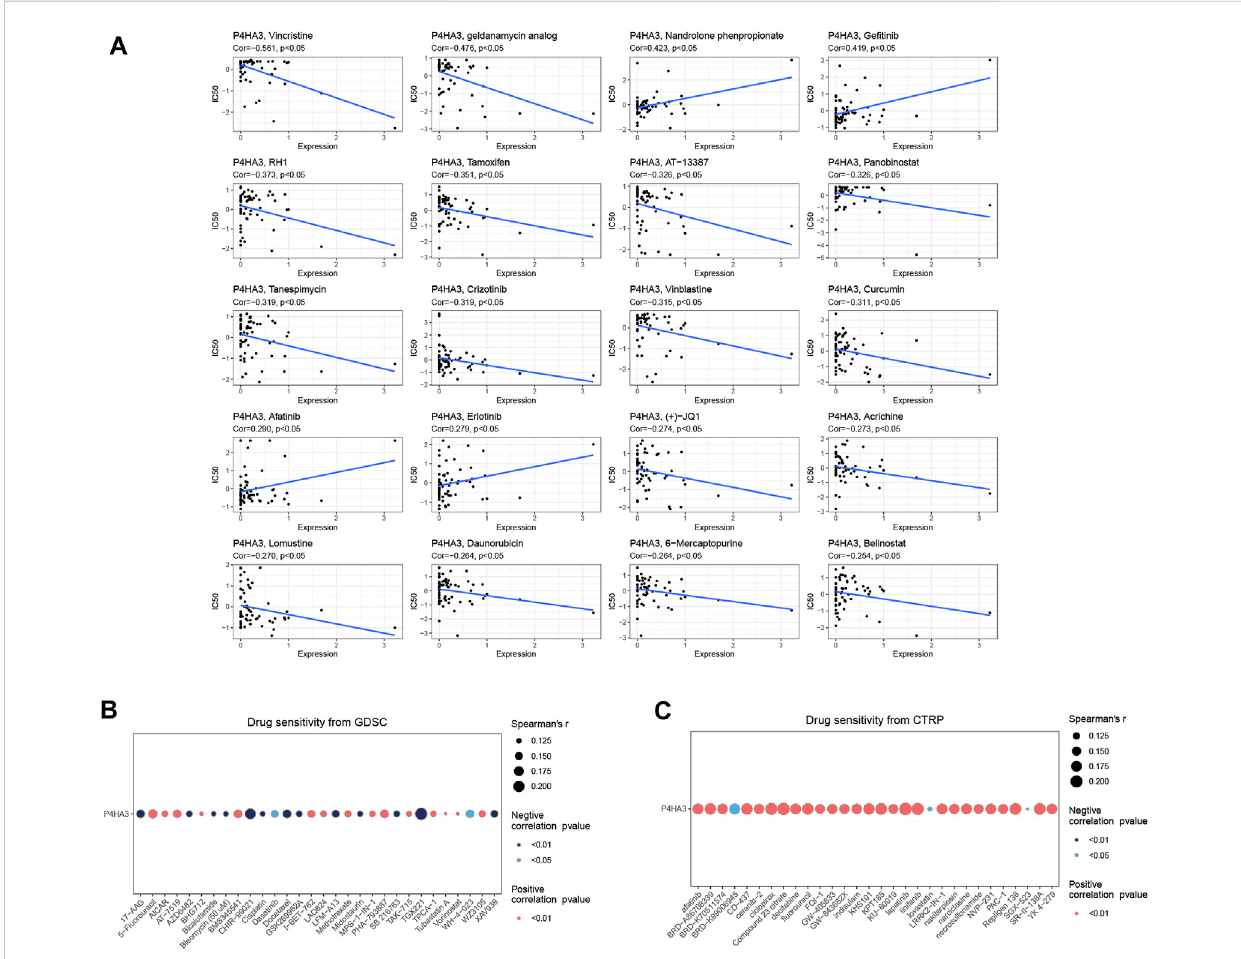
FIGURE 11 Drug sensitivity analysis. (A) In the CellMiner database, P4HA3 was shown to be closely associated with 20 drugs. (B) A Spearman association between P4HA3 and 30 drugs was performed in the GDSC database. (C) A Spearman association between P4HA3 and 30 drugs was performed in the CTRP